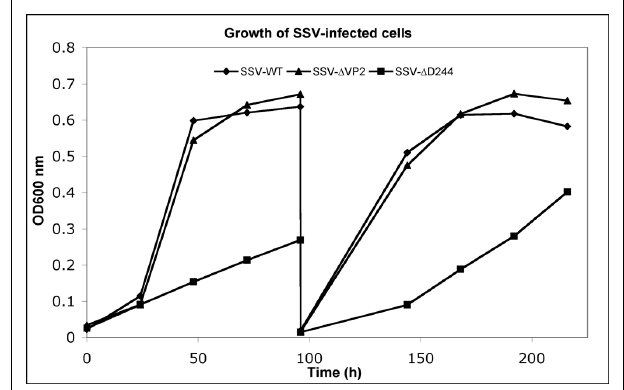
FIGURE 4 |Typical growth inhibition in liquid culture of virus constructs. Cultures of S. solfataricus G (cid:3) infected with wild-type SSV1, diamonds, SSV- (cid:2) VP2, triangles and SSV- (cid:2) d244, squares, were diluted inYS media to equal starting OD600 nm and incubated at 75 ◦ C. At the indicated times, samples were removed and the OD600 nm was determined and the presence of virus was confirmed in each culture via halo assay. After 96 h, 1 mL of cells were diluted 1:100 in freshYS media and returned to 75 ◦